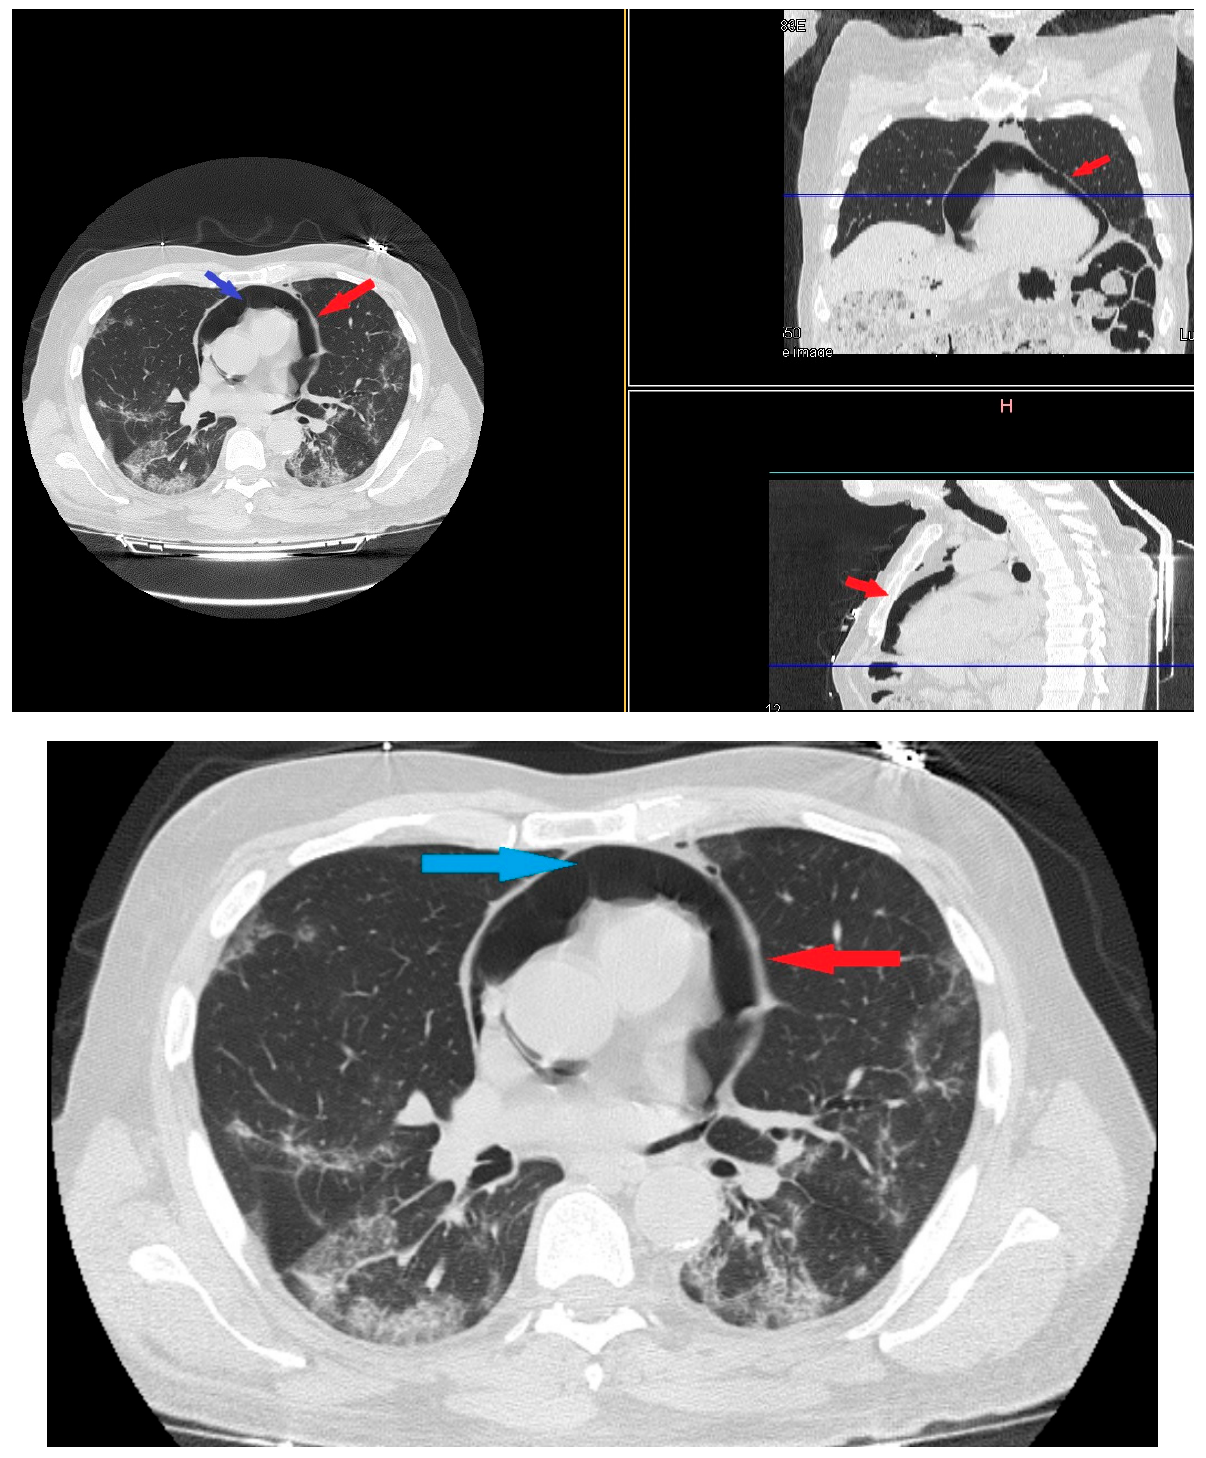
Figure 4. HRTC performed on day 22 from admission with evidence of massive pneumopericardium (red arrows) and severe presence of gas inside the pericardial sac (blue arrow). Detail of HRTC performed on day 22 show evidence of pneumopericardium (red arrow) and the severe presence of gas in the pericardium (blue arrow).